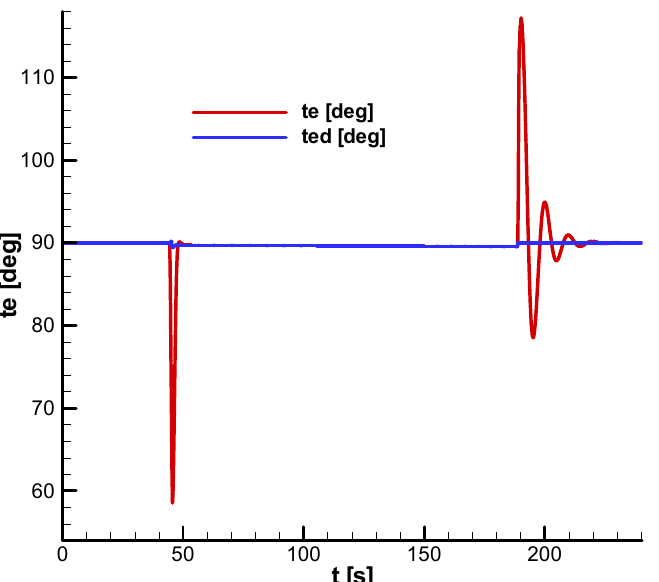
Figure 23. Diagram of the pitch angle: ted —desired pitch angle; te —achieved pitch angle (detail).